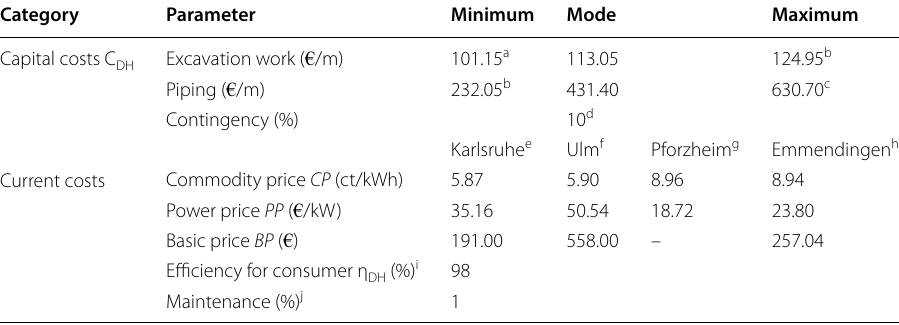
Table 6 Parameters defining the capital and current costs of the district heating